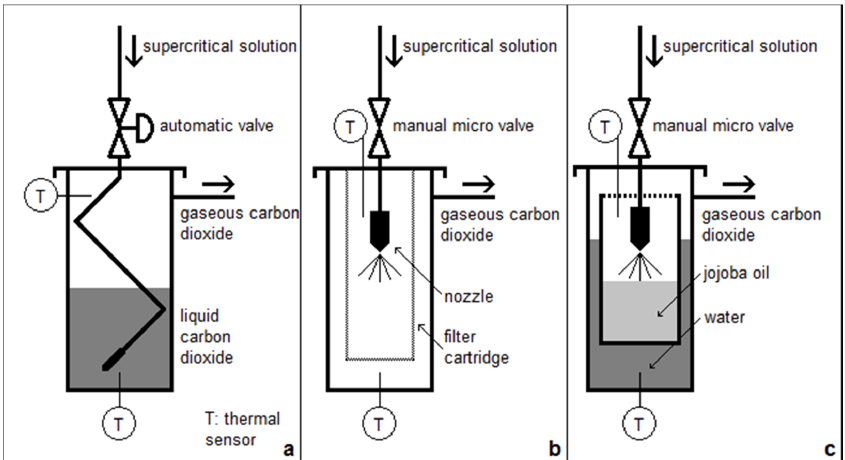
Figure 1. Different particle deposition methods from supercritical solutions. ( a ) Supercritical fluid extract by phase separation (SCF ‐ E); ( b ) Rapid Expansion of Supercritical Solutions (RESS) ‐ procedure (RESS); ( c ) modified RESS ‐ procedure (MR).